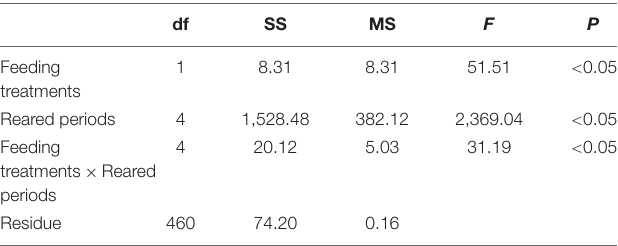
TABLE 5 | The result of two-way analysis of variance (ANOVA) for the exponential growth coefficient of Pagrus major larvae reared during 20 days. df